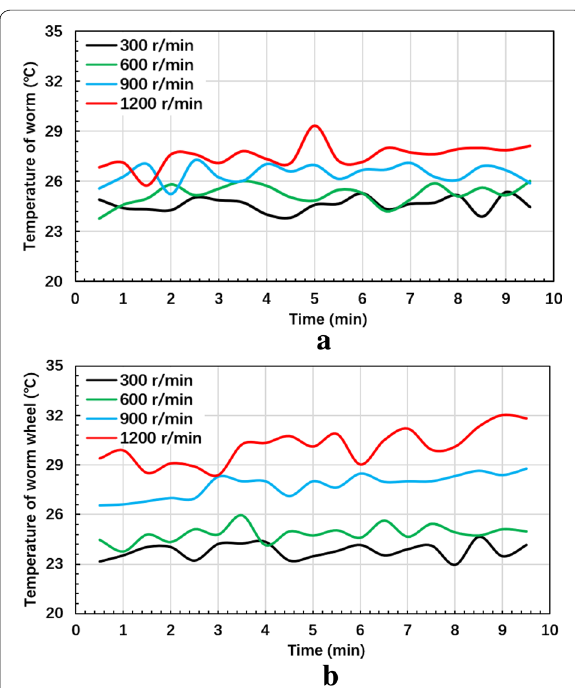
Figure 14 Comparison of experiment and simulation: a temperature of the worm, b temperature of the worm